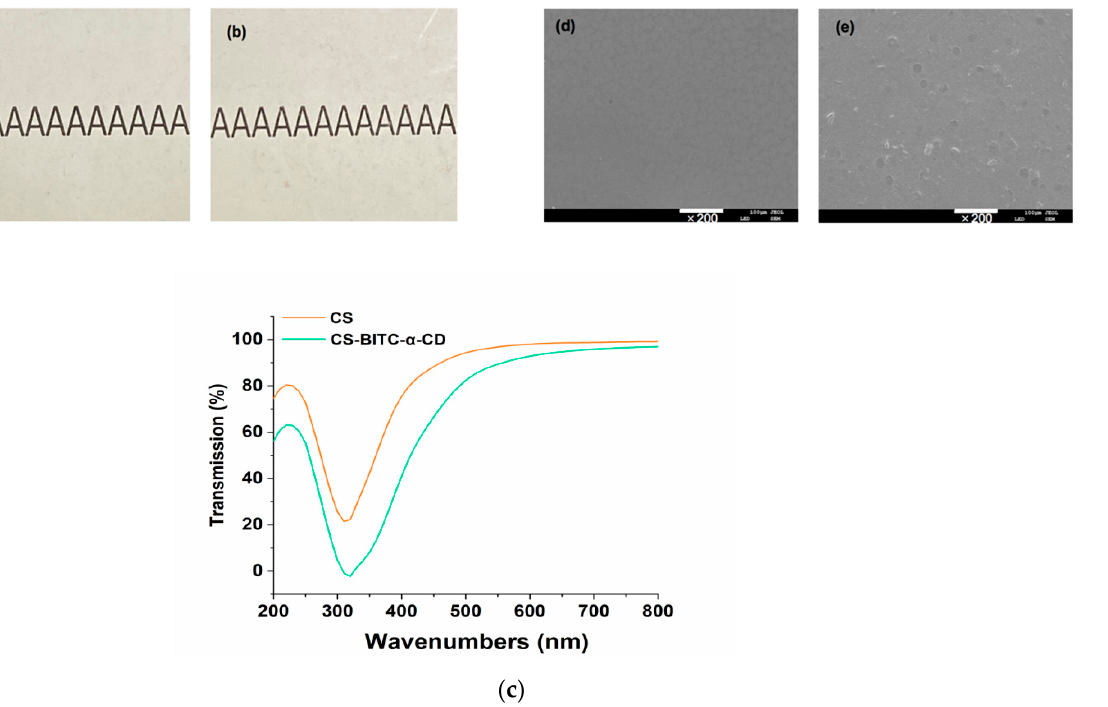
Figure 3. Appearance, light transmittance and surface morphology of the pure CS and CS − based composite films. Appearance of ( a ) pure CS and ( b ) CS − BITC −α− CD composite films; ( c ) UV–vis spectra; surface morphology of ( d ) pure CS and ( e ) CS − BITC −α− CD composite films.